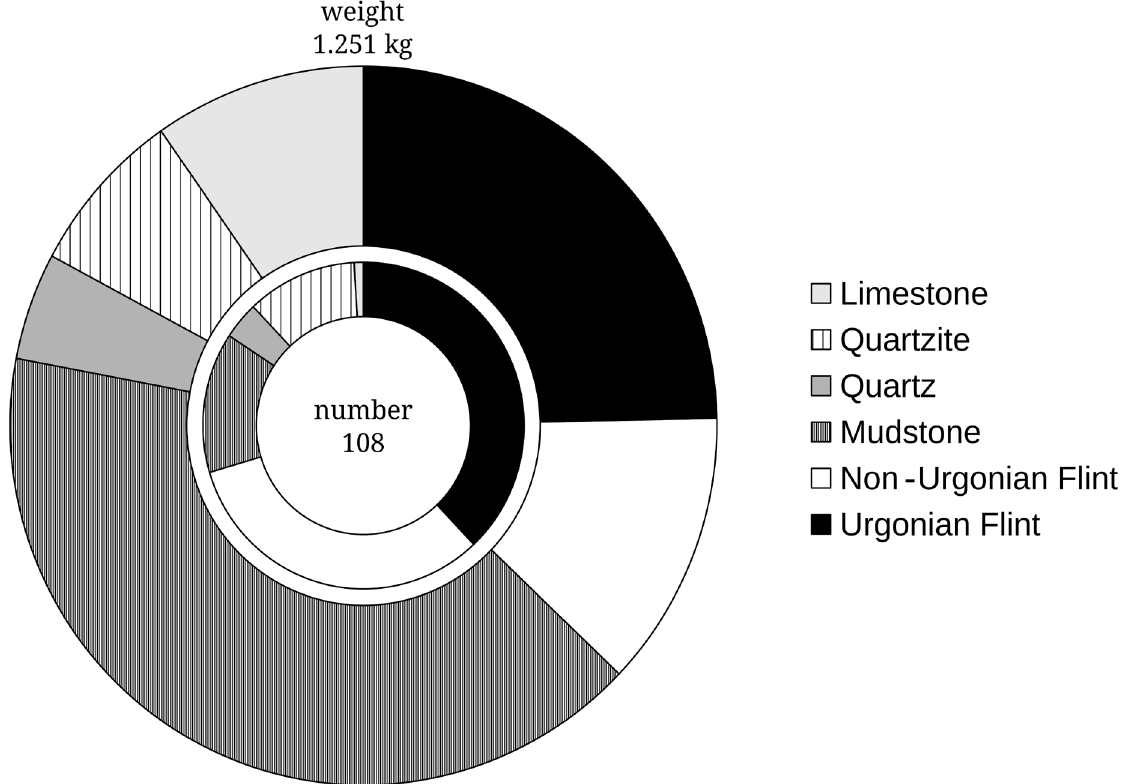
Figure 4. Relationship between raw material compositions taking into account number of artefacts and